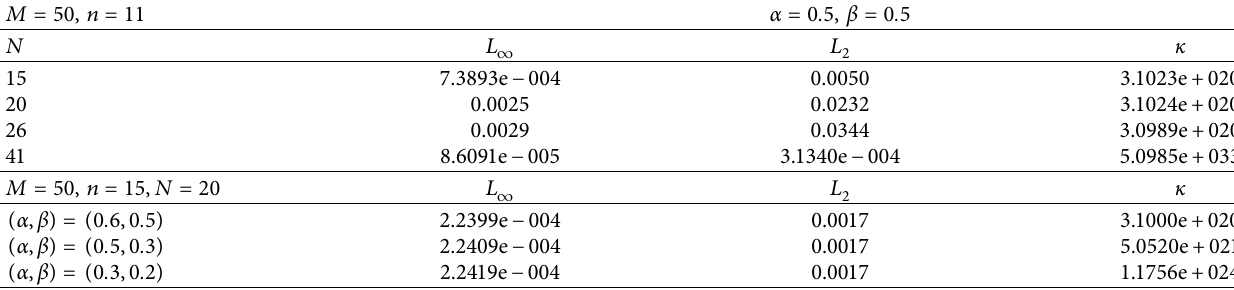
Table 3: Numerical results using the proposed numerical scheme corresponding to Problem 3.